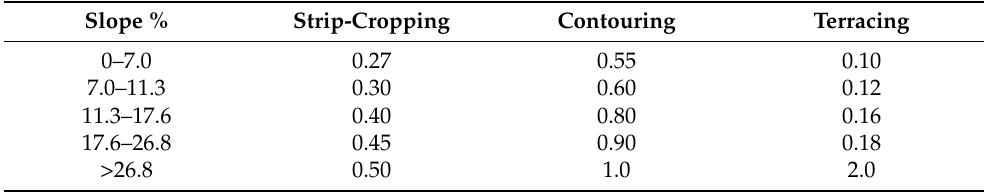
Table 3. Support practice factor values as per soil conservation practice by Shin and Noh [45].